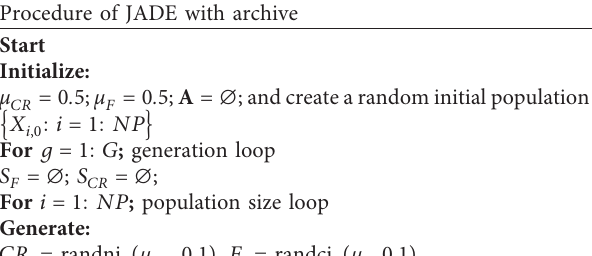
Table 1: Procedure of JADE with archive and its description [38]. Procedure of JADE with